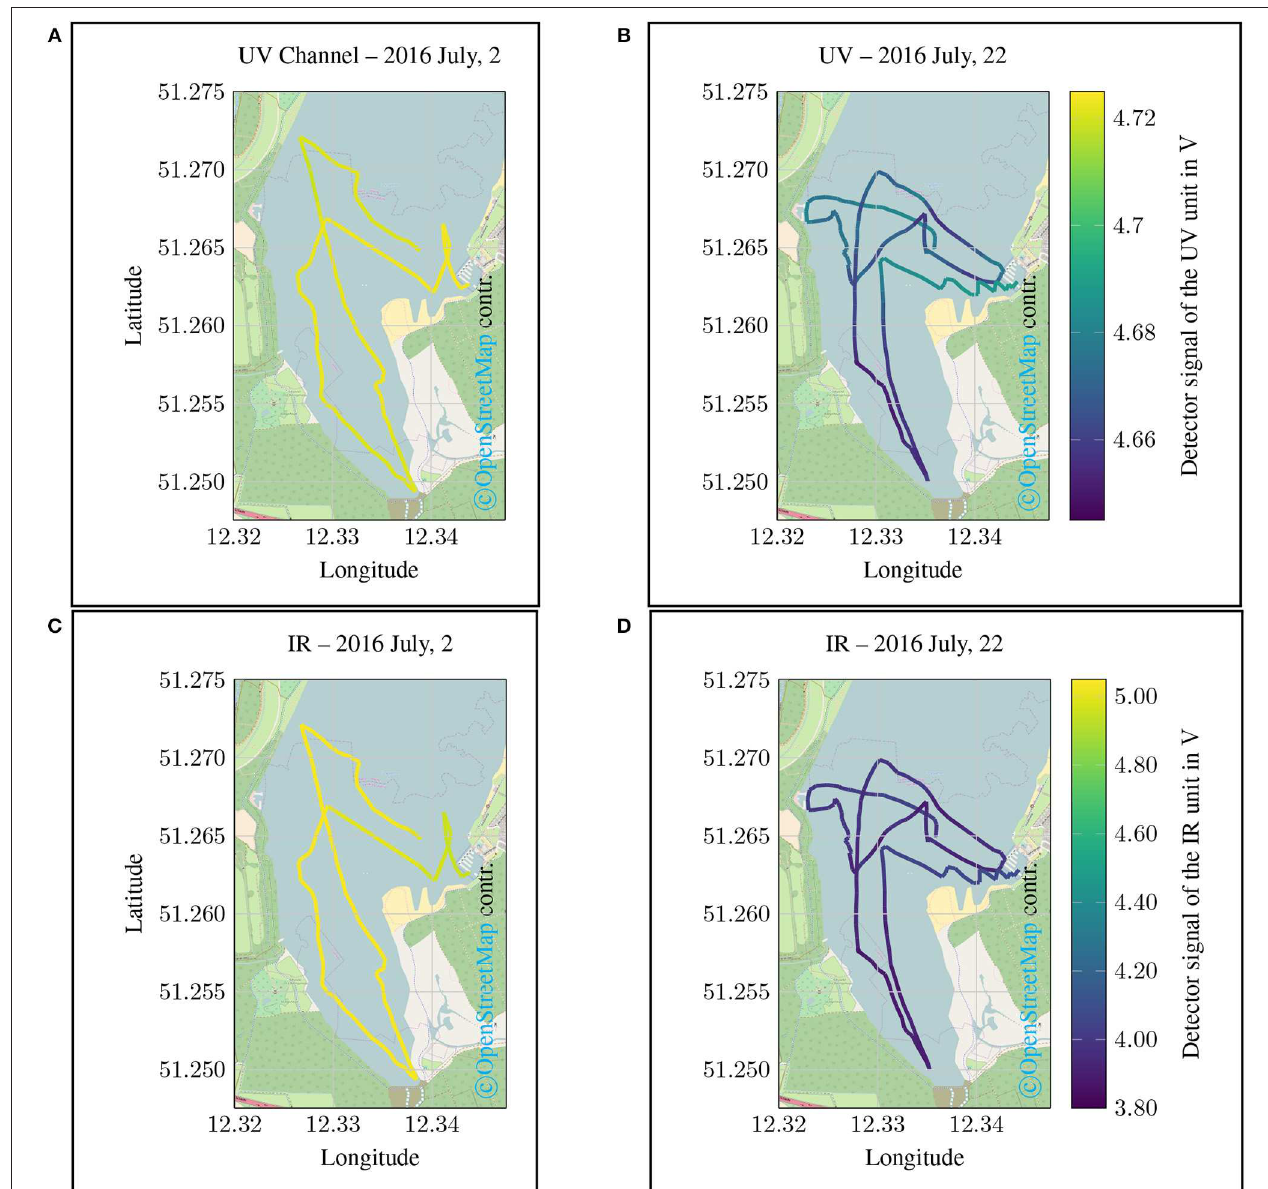
FIGURE 10 | Spatial plot of the UV detector Signal, which corresponds to the DOC content. The data were gathered using a small sailing boat at the Lake Cospuden close to the city of Leipzig (Lake Cospuden, Leipzig, Saxony, Germany). (A) and (C) are showing the results of the campaign carried out on 2 July, 2016. (B) and (D) are containing the results of the campaign carried out on 22 July, 2016. Shown are the pure measurements in V of the optical UV channel ( λ = 254 nm ). Low values in this representation mean a stronger light attenuation due to increased DOC content.